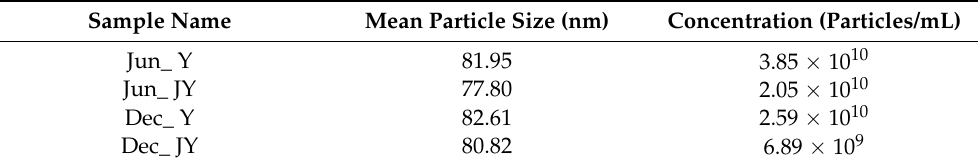
Figure 1. Milk exosomes from yak and Jeryak sampled in June and December as determined by transmission electron microscopy. Table 3. Milk exosomes particle size and concentration of yak and Jeryak sampled in June and